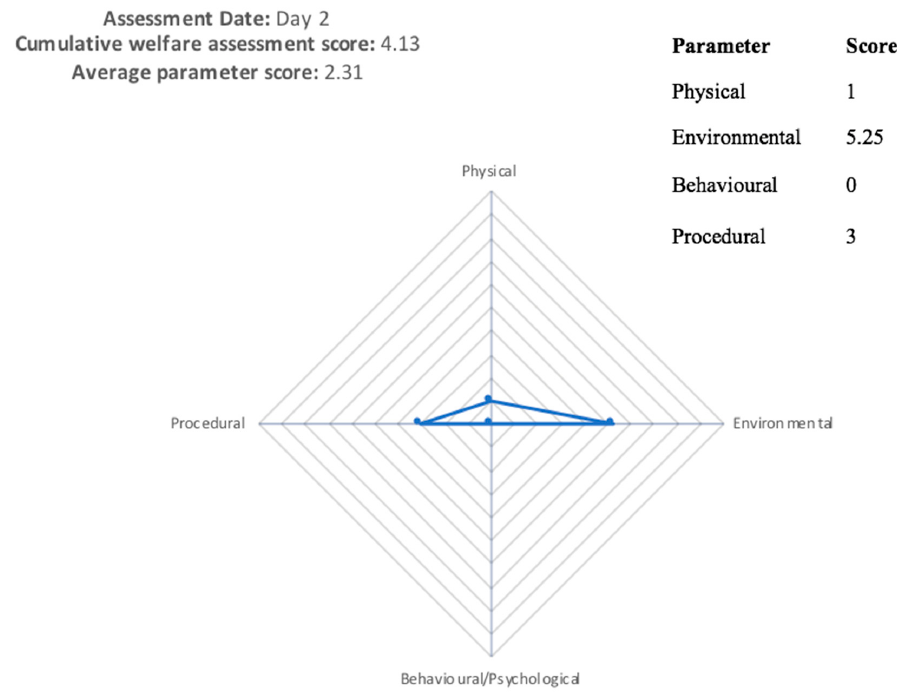
Figure 4. Cruciform grid displaying welfare assessment for a bovine on day 2, undergoing clinical examination (including rectal temperature), showing a cumulative welfare assessment score (CWAS) of 4.13 when behavioural data were unavailable. This CWAS score is calculated from the area of the grid.